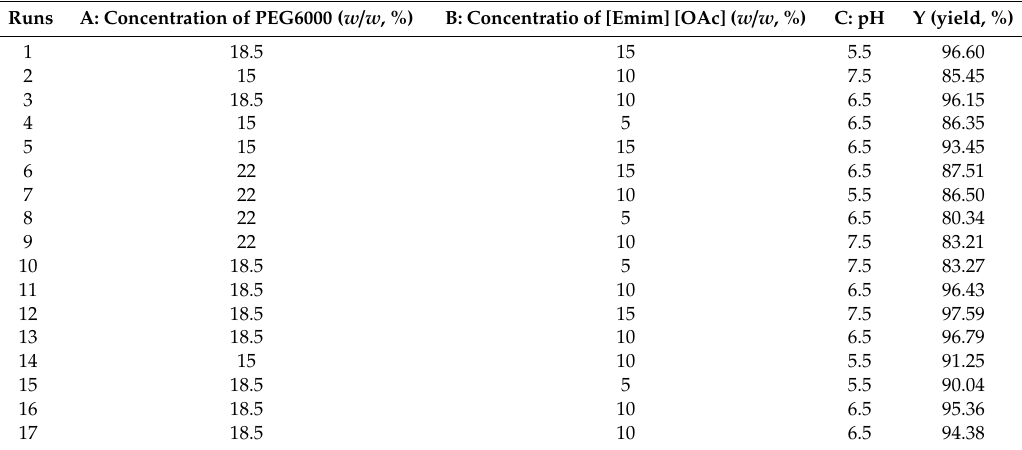
Table 4. The yield of capsaicin in TAPPIR technology using a Box–Behnken